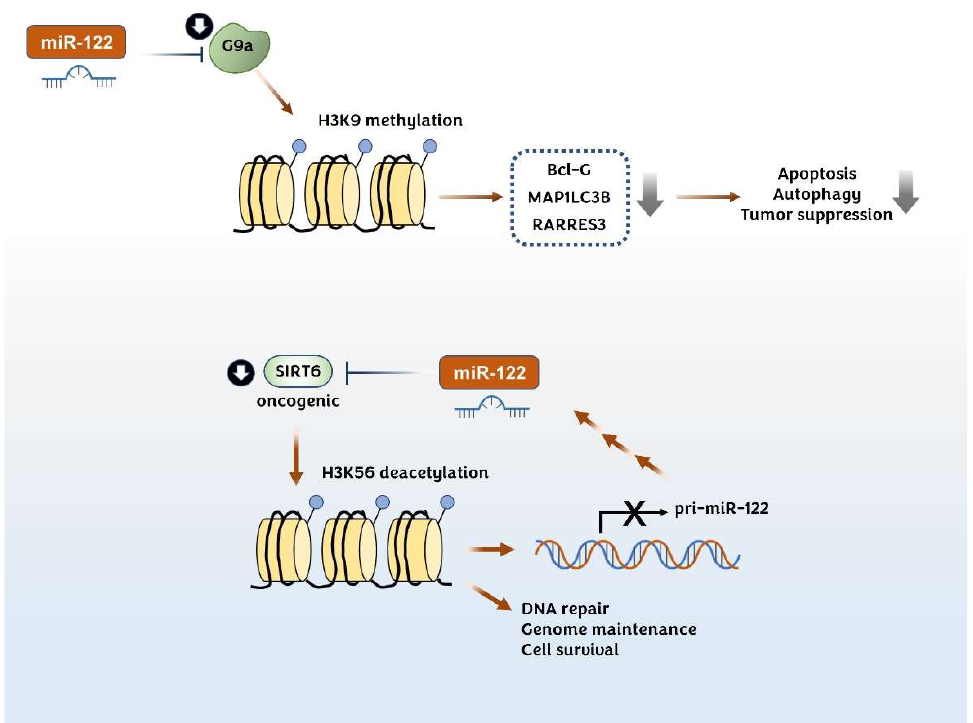
Figure 5. Effect of miR-122 on the epigenetic regulation of cancer cells. H3K9 methylation by G9a reduces the expression of the proapoptotic regulators Bcl-G, MAP1LC3B, and RARRES3 in hepatocellular carcinoma (HCC) (upper). H3K56 deacetylation by SIRT6 is involved in DNA repair, genome maintenance, and cell survival leading to carcinogenesis (lower). miR-122 suppresses the progression of HCC by directly downregulating G9a and SIRT6. SIRT6 and miR-122 reciprocally regulate each other via a negative feedback mechanism.